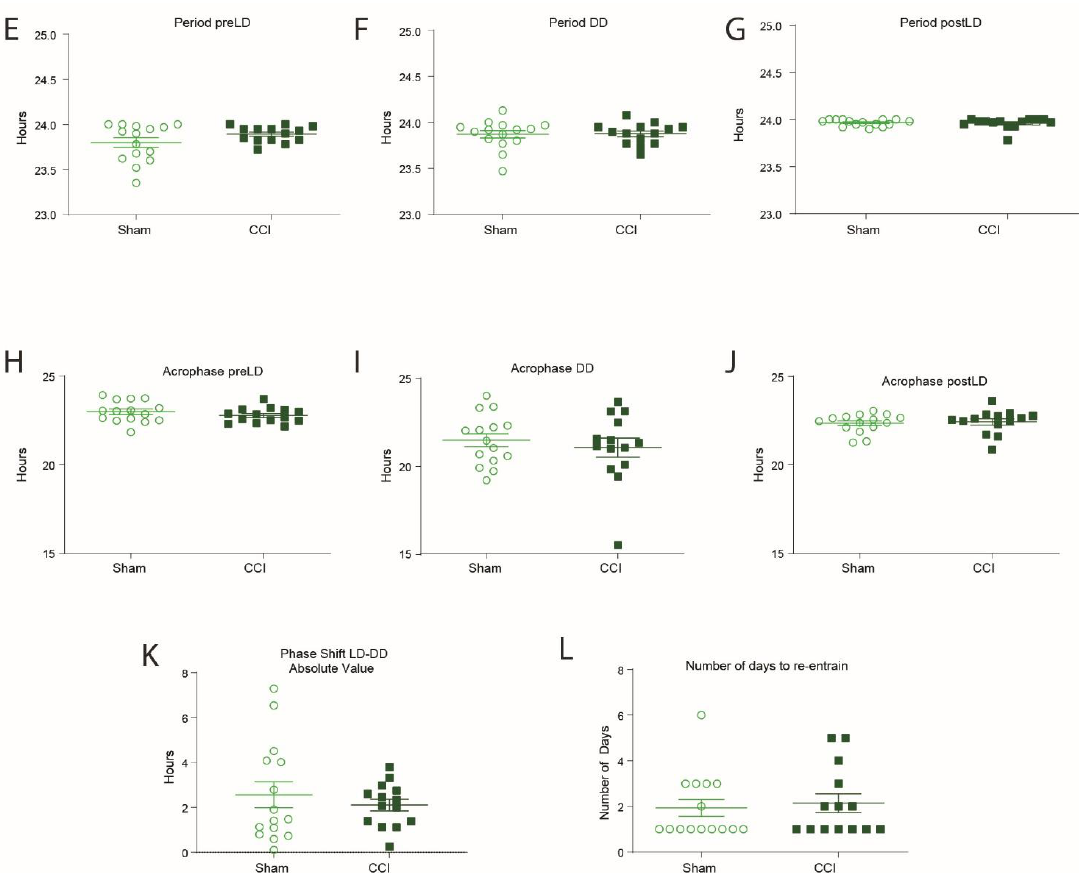
Figure 4. The effect of CCI on circadian wheel-running behavior. ( A ) Schematic of experimental protocol. Mice were exposed to CCI or sham injury, then placed in individual cages the following morning at ZT0. The mice were acclimatized under normal 12 h:12 h light:dark (LD) cycles for 7 d before a 15 d dark:dark (DD) period. Mice were re-entrained to a 12 h:12 h LD cycle for a further 7 d. Spontaneous activity was tracked by running wheel activity. ( B ) Representative image of actogram generated from running wheel activity. Activity counts (in black) are double-plotted over 48 h to see temporal patterns in activity. Yellow background indicates lights on in the behavior room, white background indicates lights were off in the behavior room. Each new 24 h period (right side) is repeated on the line below (left side) to allow for clear visualization of phase shifts. ( C , D ) CCI mice ran significantly less than sham during the initial 7 day LD cycle, but reached the same running distances as shams during the 15 day DD and final 7 day LD cycles. ( E – G ) There was no effect of CCI on circadian period in the pre-LD, DD or post-LD phases. ( H – J ) There was no effect of CCI on acrophase in the pre-LD, DD or post-LD phases. ( K ) There was no effect of CCI on phase shift between the pre-LD and the DD phase between injury and sham. ( L ) There was no effect of CCI on the number of days it took to re-entrain to the post-LD phase. Unpaired t -test * p = 0.022 ( n = 14 CCI, 15